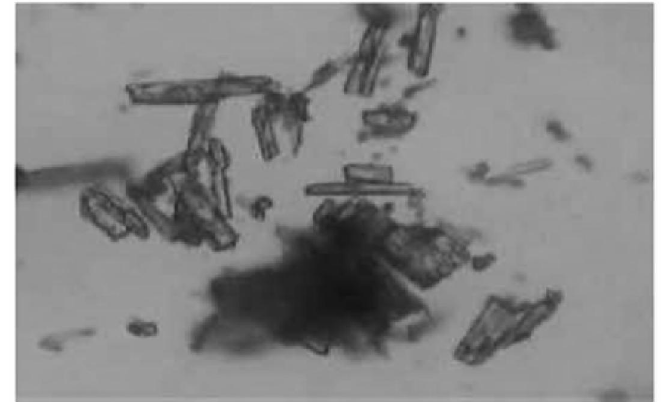
Figure 3. SEM image of new polymorph of